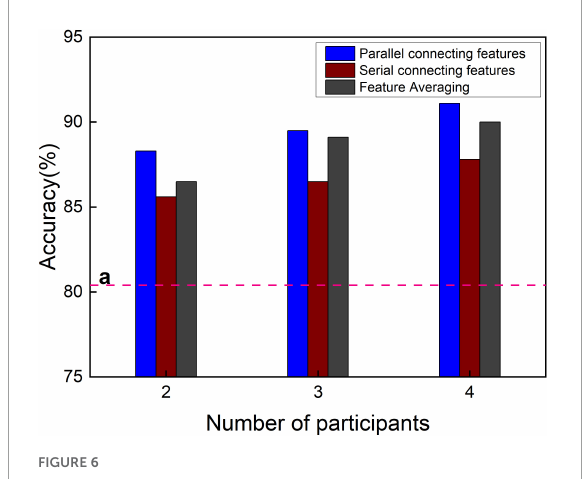
FIGURE6 Total classification accuracy of three fusion methods under different number of participants. The line “a” is the total classification accuracy of the single